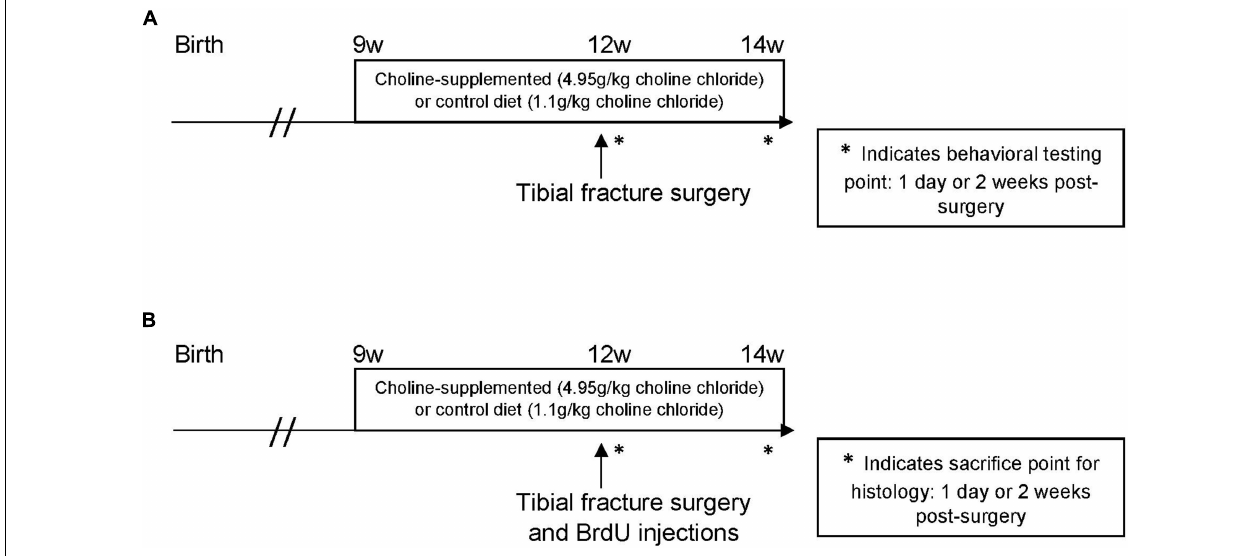
FIGURE 1 | Experimental timelines. (A) The effect of choline supplementation and tibial fracture surgery on hippocampal-dependent behavior. Nine-week-old C57/BL6J male mice consumed a synthetic diet that was supplemented with choline or a synthetic control diet without added choline. These diets were consumed for 3 weeks before a tibial fracture surgery. All mice underwent behavioral testing (NOR and open field) 1 day after surgery, with a habituation trial the day of surgery. Mice received another 2 weeks of choline-supplemented or control diet after surgery. After these 2 weeks, they underwent the same behavioral testing. * indicates behavioral testing point: 1 day or 2 weeks post-surgery. (B) The effect of choline supplementation and tibial fracture on histological measures. Nine-week-old C57/BL6J male mice were treated with a choline-supplemented diet or a synthetic control diet for 3 weeks before a tibial fracture surgery. The first group of mice was euthanized 1 day after surgery to analyze microglia, astrocytes, and young neurons. The second group received another 2 weeks of choline-supplemented or control diet after surgery. After these 2 weeks, they were euthanized to measure microglia, astrocytes, and young neurons. * indicates sacrifice point for histology: 1 day or 2 weeks